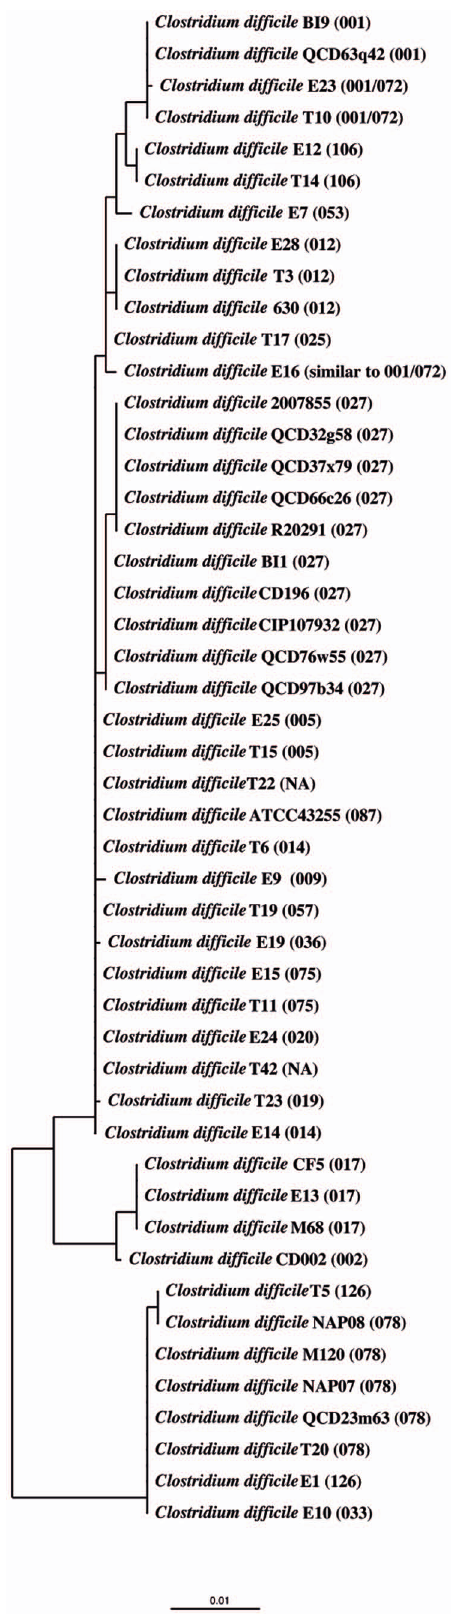
Figure 1. DNA gyrase A gene-based dendrogram. Neighbor joining dendrogram reflecting the similarity for 48 C. difficile